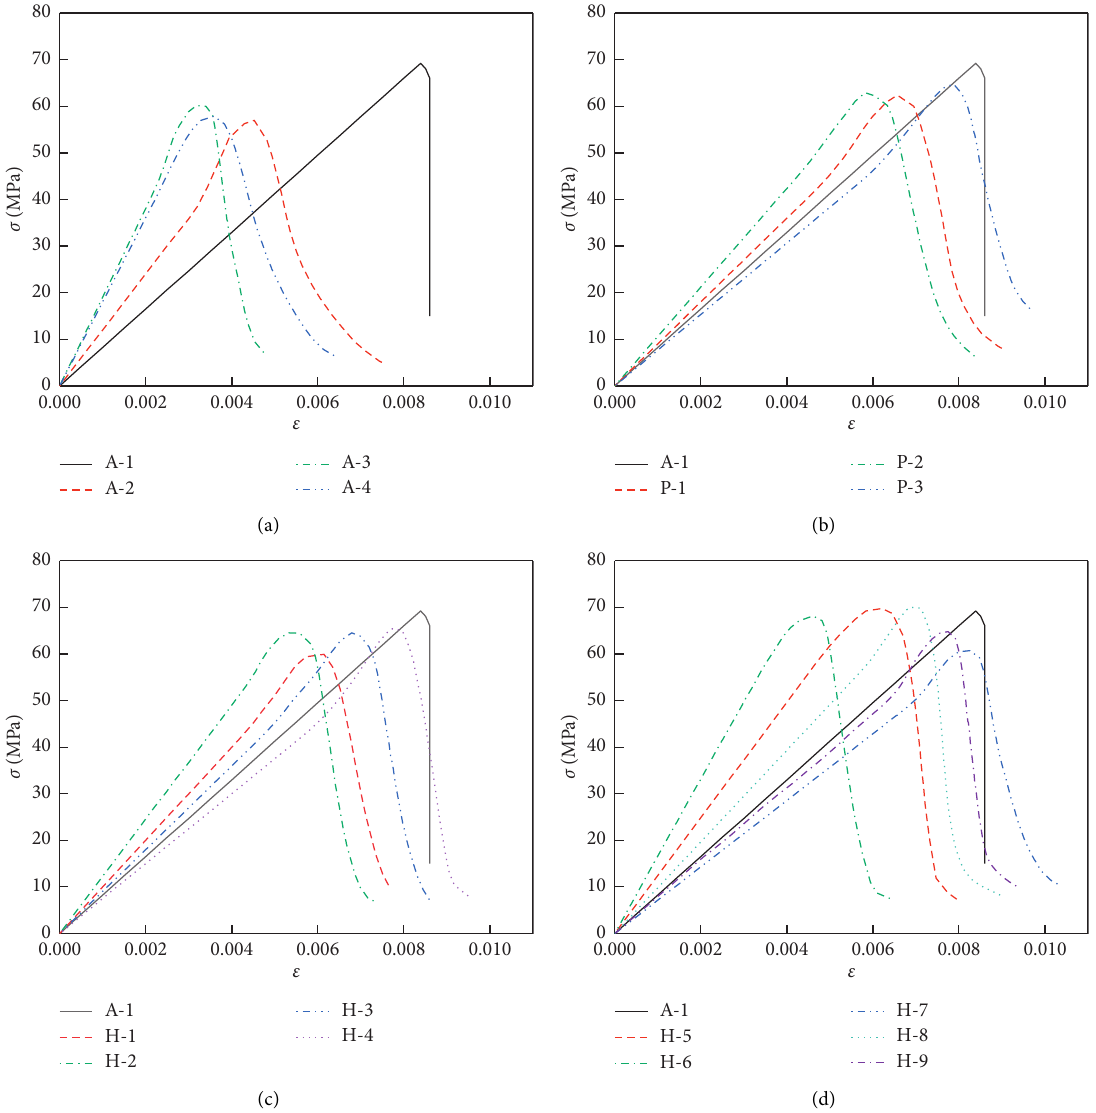
Figure 4: Comparison of cubic compressive stress-strain curves with different fiber content (before the peak). (a) PC and BFRC, (b) PC and PFRC, (c) PC and H-1 ∼ H-4, (d) PC and H-5 ∼